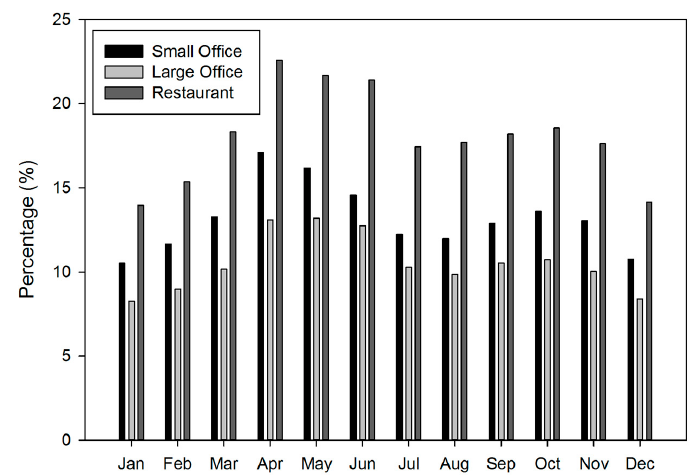
Figure 3. Percentage of the building load provided by the ORC-EES for each of the evaluated buildings.